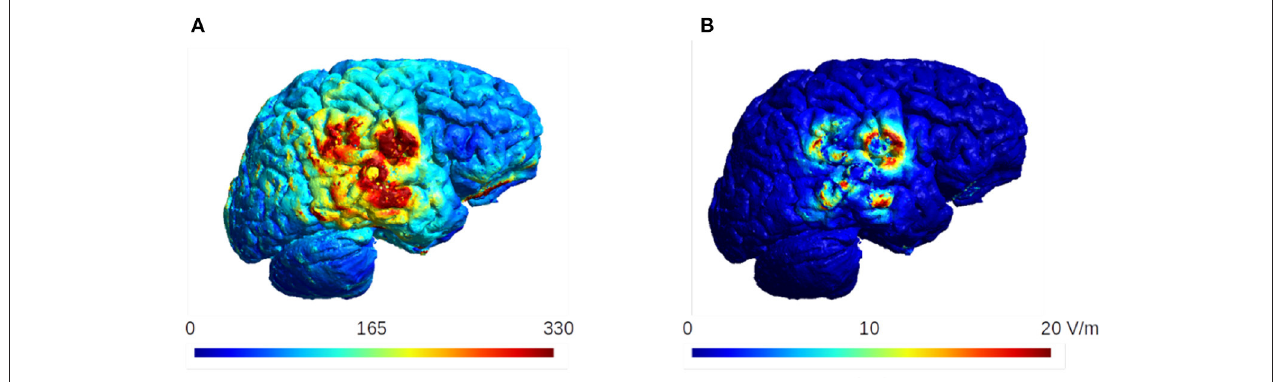
FIGURE 14 | The mean and the standard deviation of the electric field intensity on the gray matter surface. The burr holes are located directly above the tumor and overlapped with the transducer array (60 degrees, Figure 8 ). These are the optimal configuration for the burr hole surgery and the optimal layout for the electrode arrays. The standard deviation is ∼ 20 V/m in this case, which is < 10% of the mean values in the region of